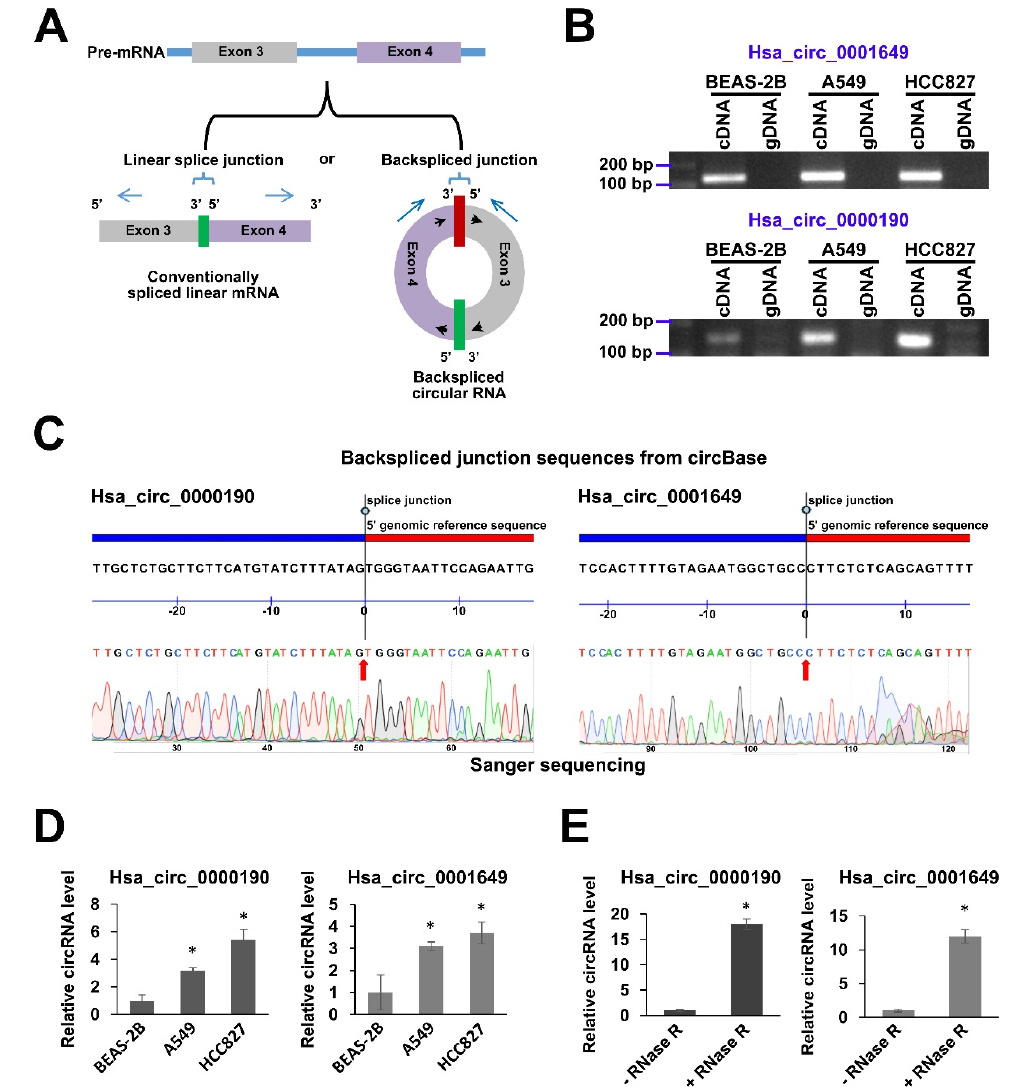
Figure 2. Validation of expression of hsa_circ_0000190 and hsa_circ_0001649 in LC cell lines. ( A ) Schematic illustration of a circRNA and its linear form counterpart. The divergent primers (blue arrows) across the backspliced junction can only amplify the circRNA form. ( B ) Agarose gel electrophoresis analysis of the sizes of RT-PCR amplicons of hsa_circ_0000190 and hsa_circ_0001649 amplified from cDNA templates of the indicated cell lines. gDNA templates were used as a negative control. ( C ) Sanger sequencing of RT-PCR amplicons of hsa_circ_0000190 and hsa_circ_0001649 ( B ) aligned to the respective sequences of these circRNAs retrieved from the circBase database. ( D ) qRT-PCR analysis of expression of hsa_circ_0000190 and hsa_circ_0001649 in BEAS-2B, A549 and HCC827 cell lines. The results expressed as fold change relative to BEAS-2B. ( E ) qRT-PCR analysis of expression of hsa_circ_0000190 and hsa_circ_0001649 in A549 cells, with or without prior treatment of total RNA with RNase R. The results expressed as fold change relative to—RNase R. In ( D ) and ( E ), fold changes were calculated using ddCt method with GAPDH mRNA used as a normalization control. Mean fold changes from three independent experiments are shown with standard deviation error bars. * p < 0.001 (Student’s t -test).